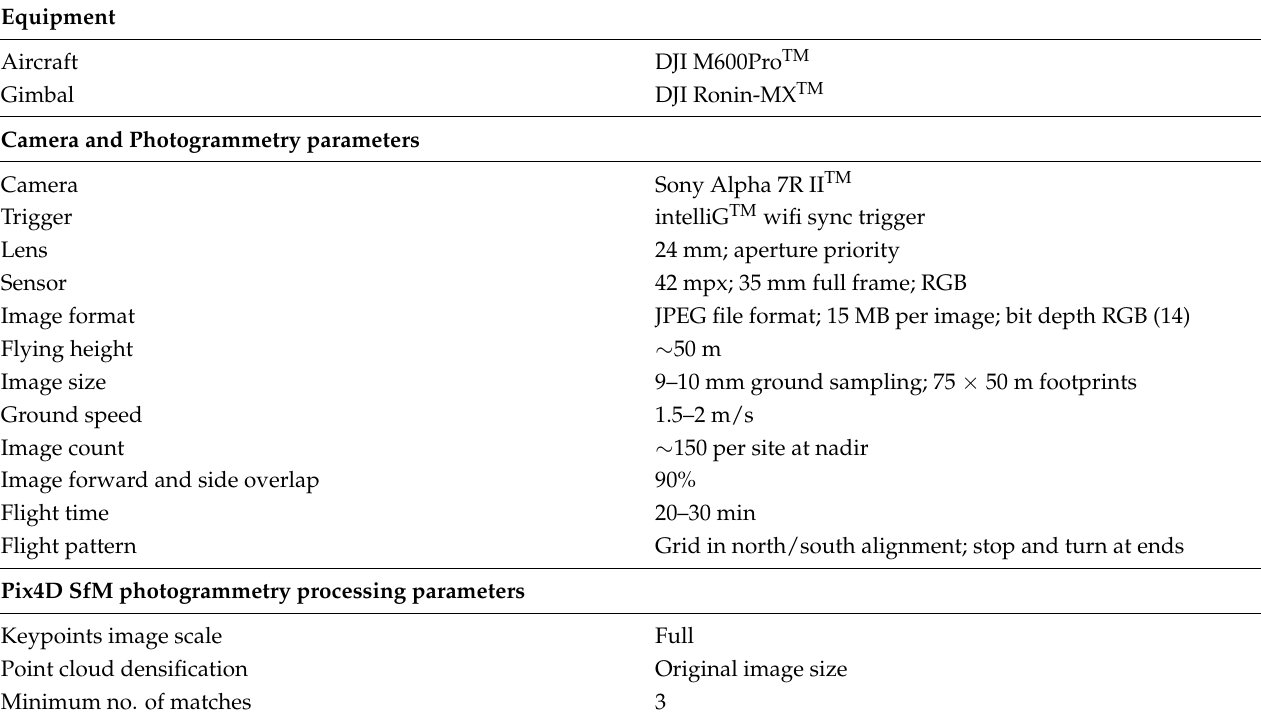
Table 2. RPAS flight mission and processing